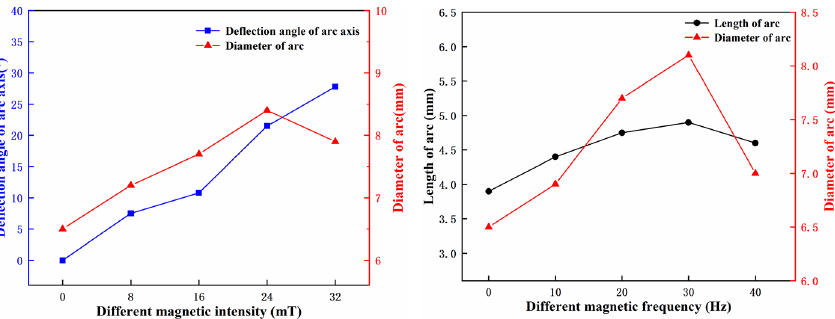
Figure 11. Average droplet diameter and transition frequency under different magnetic intensity and frequency.